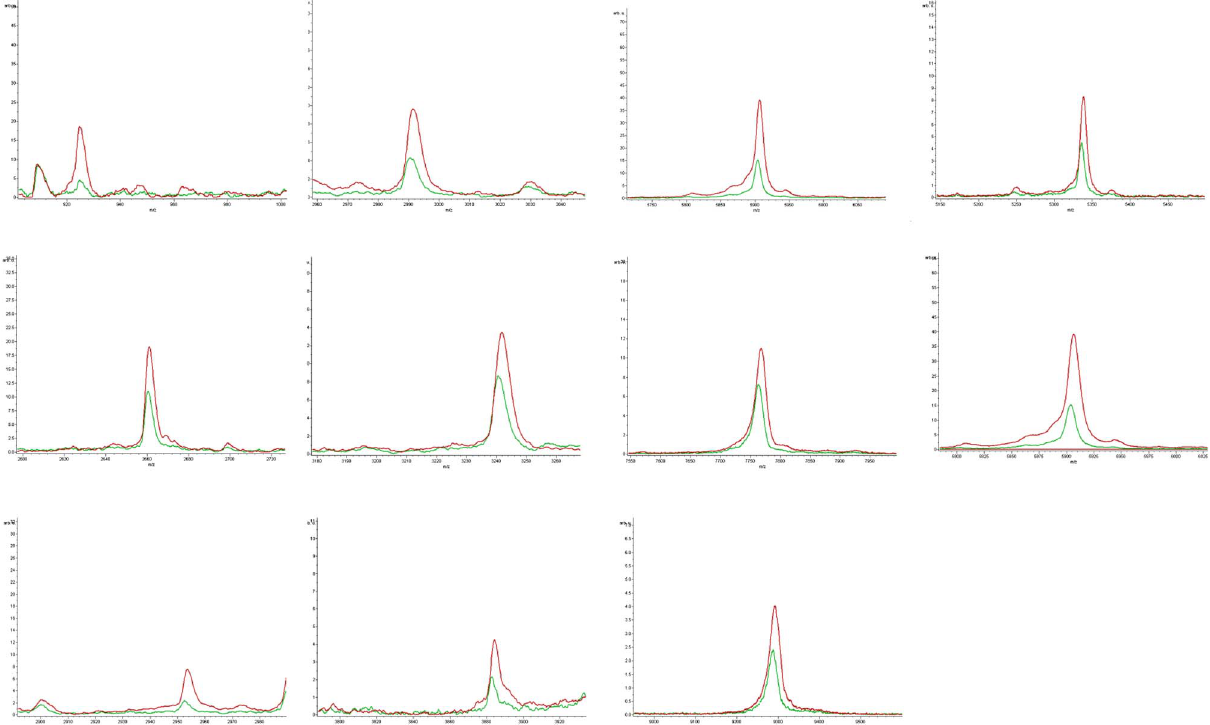
Figure 4. Peptide peaks with features of down-regulation. Compared with the healthy controls (red line), the down-regulated peaks of the newly developed advanced schistosomiasis (NDAS) group are shown as a green line, including 11 peaks with m/z 924, 2661, 2953, 2991, 3241, 3884, 5337, 5905, 5943, 7766 and 9289.